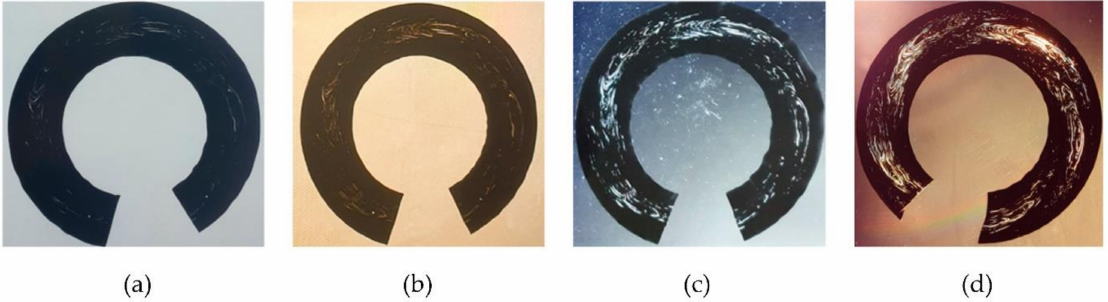
Figure 6. The 100- µ m shaving viewed under: ( a ) white, ( b ) monochromatic, ( c ) cross-polarized white, and ( d ) cross-polarized monochromatic